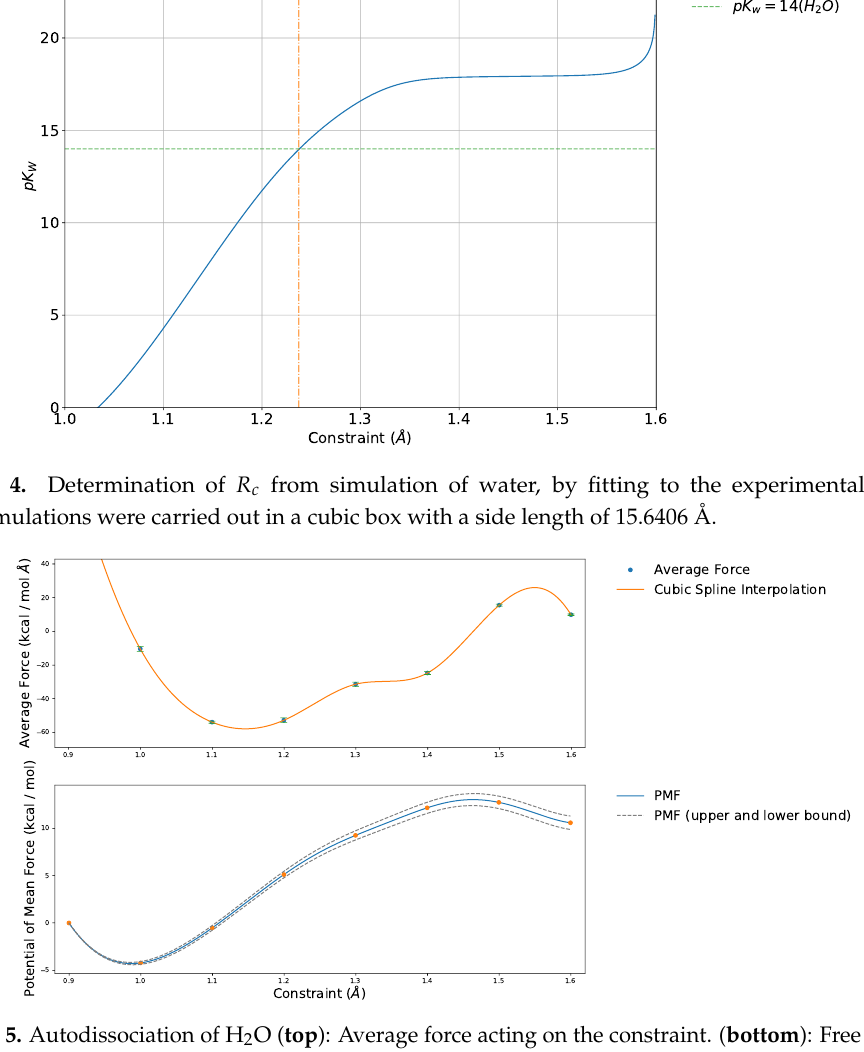
Figure 5. Autodissociation of H 2 O ( top ): Average force acting on the constraint. ( bottom ): Free energy obtained by integrating the average forces. Note the drop in free energy at 1.5 Å is caused by the reprotonation of OH –